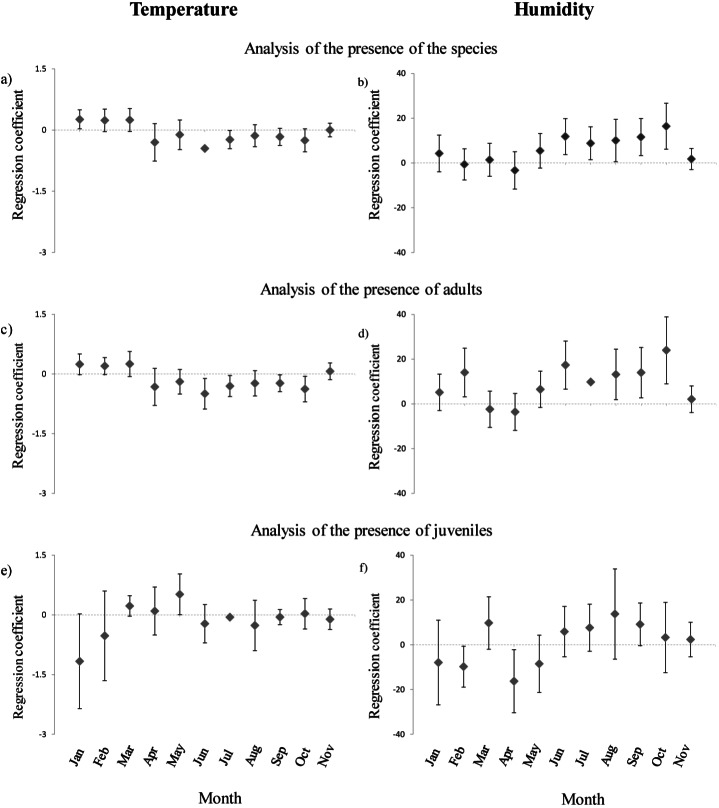
Annual variation of the coefficients of regressions between presence/absence of cave salamanders, temperature and humidity.(A)–(B): results of regression models analyzing all individuals encountered; (C)–(D) results of models analyzing adults only (E)–(F) results of models analyzing juveniles only. Results for December were not reported due to small sample size.